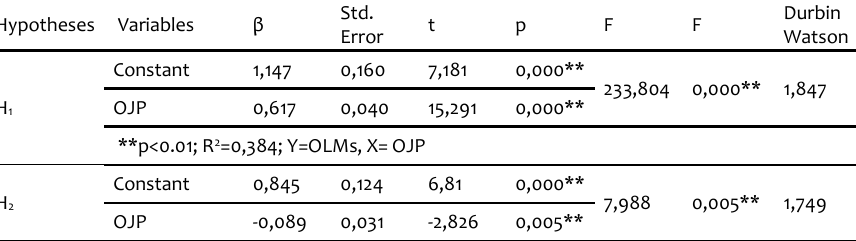
Table 3. Table 3. Linear Regression Analysis